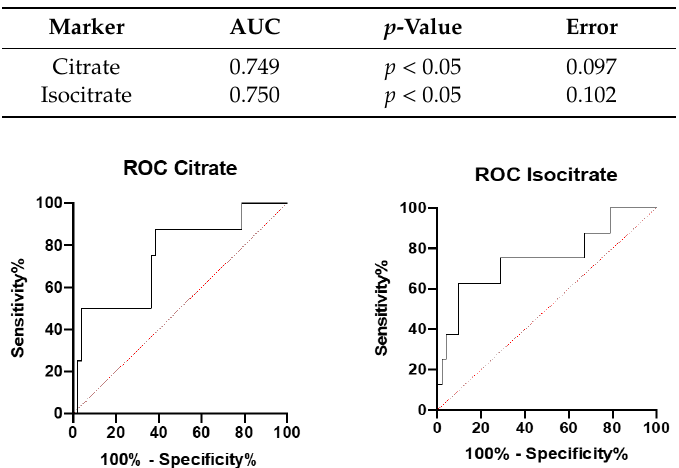
Table 3. Evaluation of isocitrate and citrate as mitochondrial dysfunction markers in NAFLD. AUC—area under the curve.